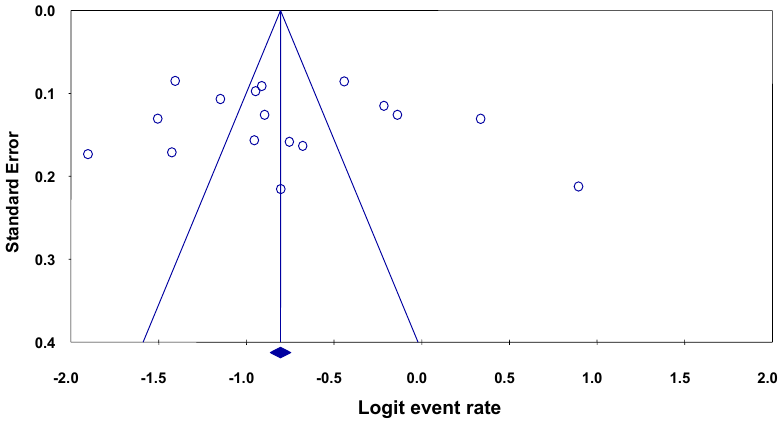
Figure3: Funnelplotdepictingpublicationbias of studies reporting the bacterial profiles causing septicemia and/or bacteremia in different parts of